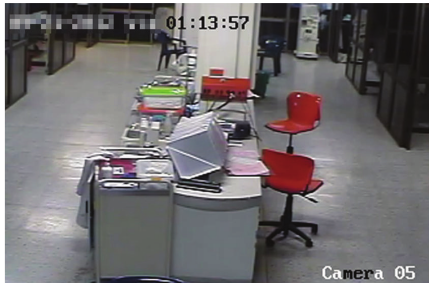
Figure 3: Video of area between ICU cubicles. This area was under observation for evaluating the team behavior during mobilization of patients outside the cubicles. Photo: